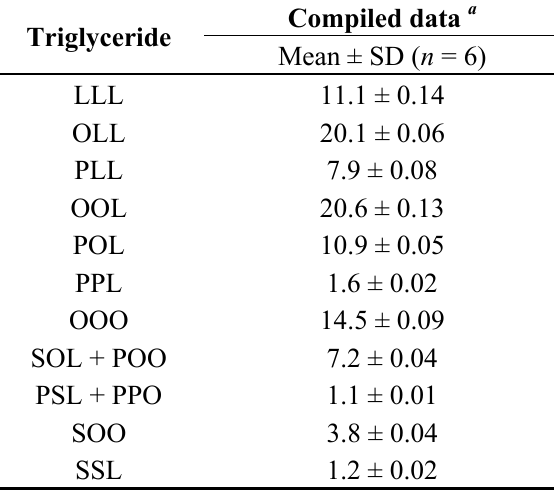
Table 8. Composition of triglycerides in refined sesame oil. The fatty acids are designated as linoleic (L), oleic (O), palmitic (P), and stearic (S)